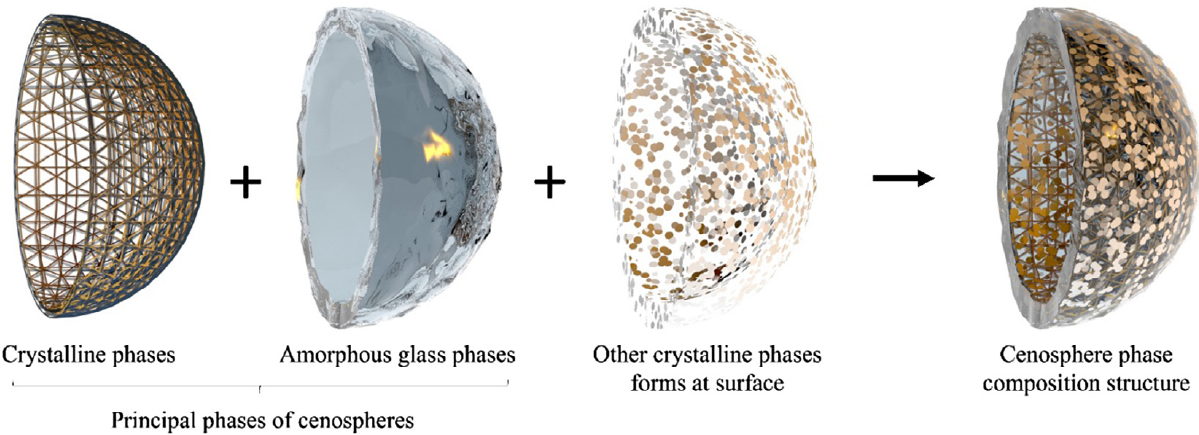
Figure 1: Schematic phase composition and structure of a cenosphere